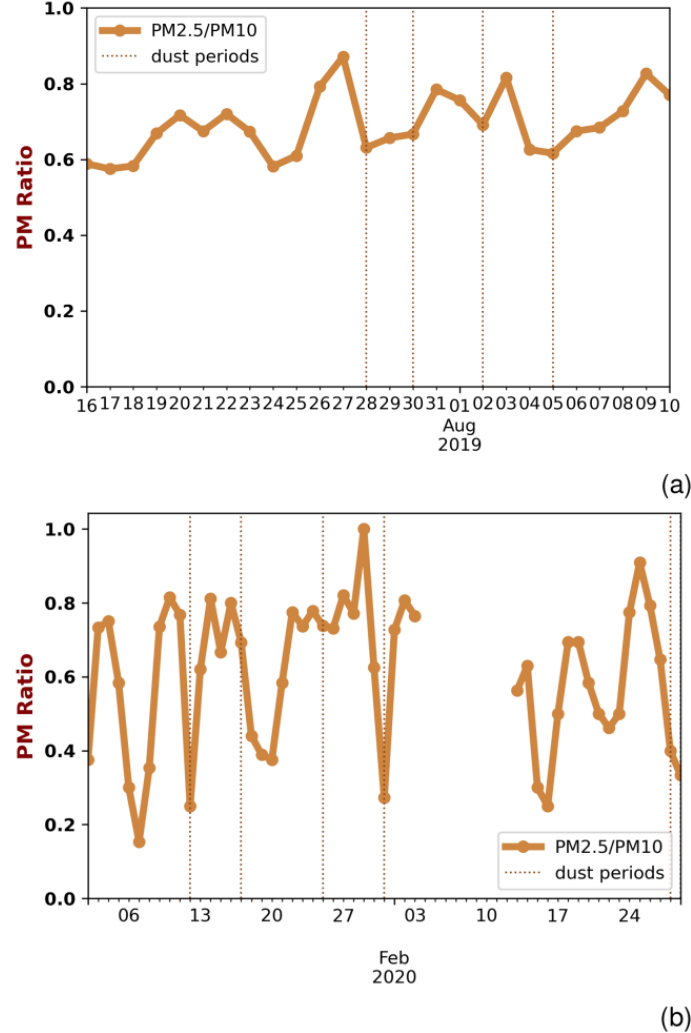
Figure 3. PM2.5 and PM10 ratio monitored during ( a ) the summer and ( b ) winter PANACEA campaigns in Thessaloniki station. The periods with transported dust particles, according to the Hybrid Single Particle Lagrangian Integrated Trajectory model (HYSPLIT; https://www.arl.noaa.gov/hysplit/ (accessed on 6 October 2022)) are also plotted with dashed lines.